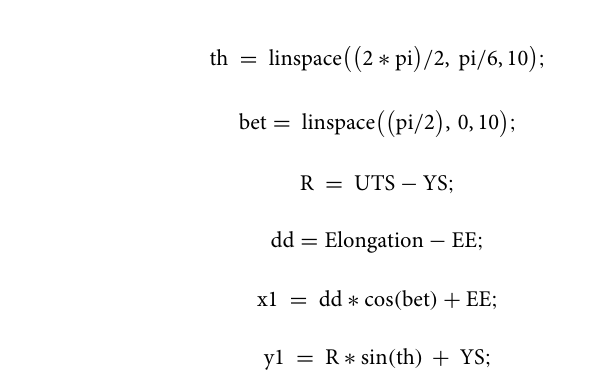
Figure 8. A comparison in values of ultimate tensile strength among FCC, BCC, and